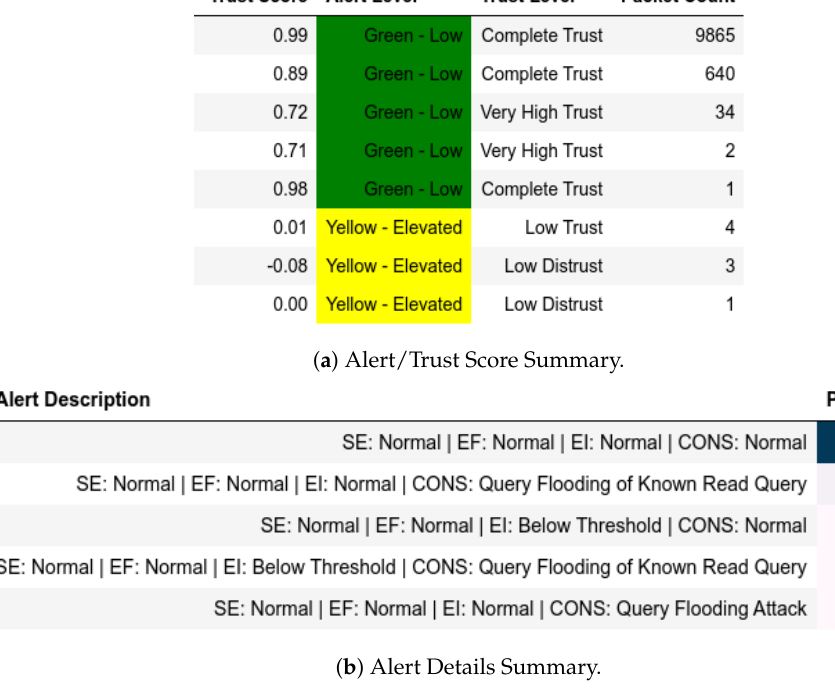
Figure 35. Client: ATENA H2020 dataset internal test- H s in query flooding